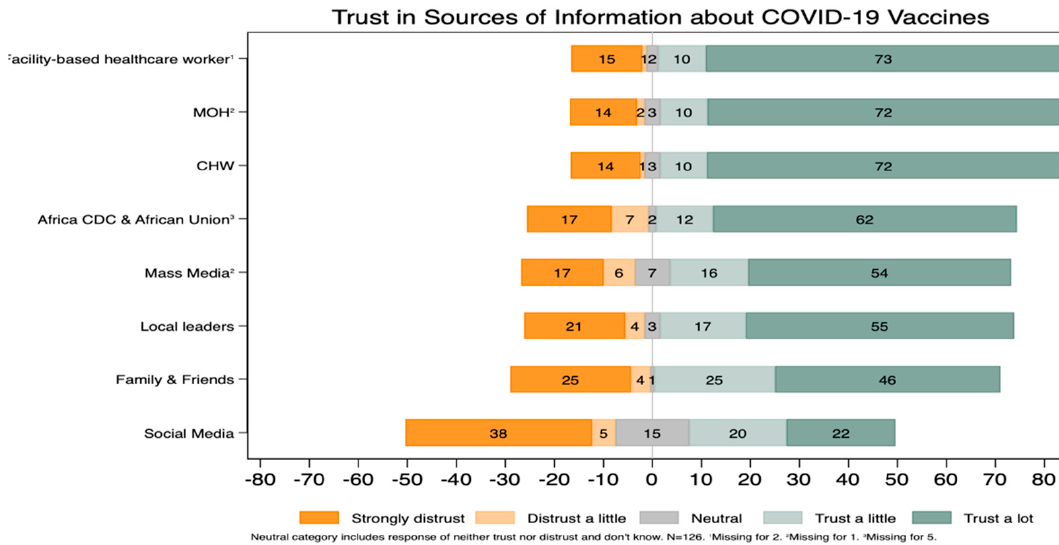
Figure 4. Trust in sources of information about COVID-19 by